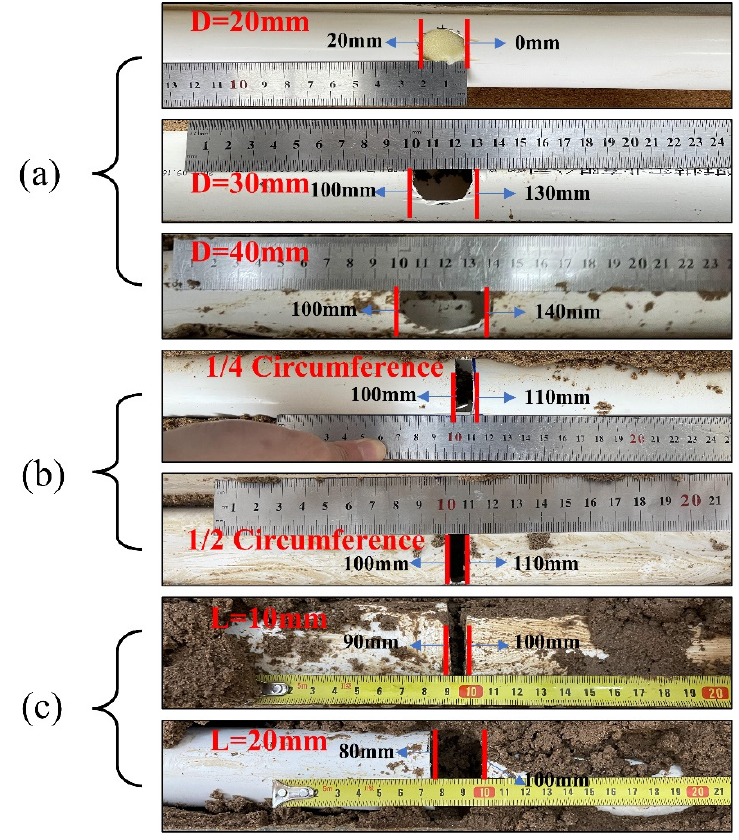
Figure 5. Types of experimental groups: ( a ) wall perforation group; ( b ) circumferential damage group; ( c ) vertical damage group (black fonts for scale reading).